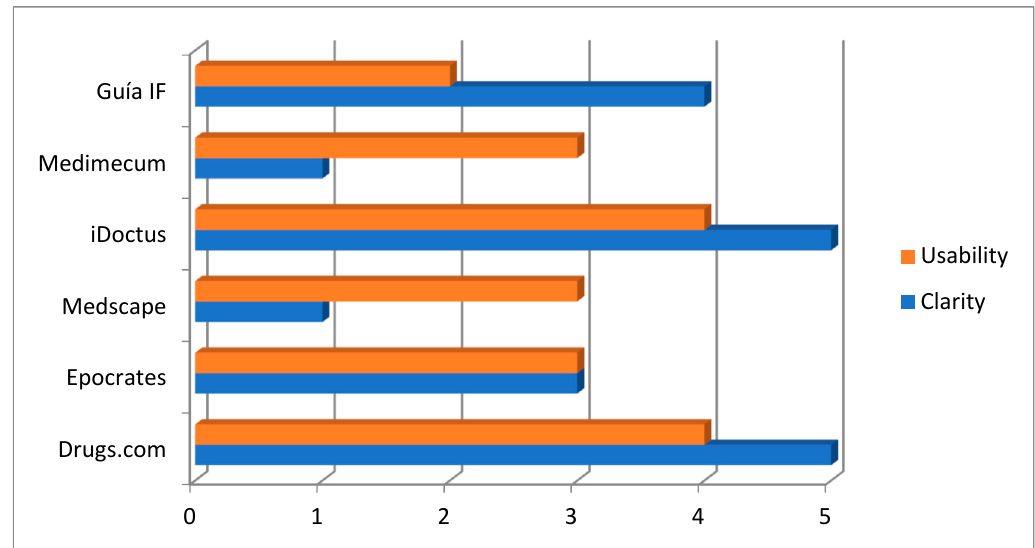
Figure 1. Perceived usability of the software platform and clarity of the mechanism of action and the